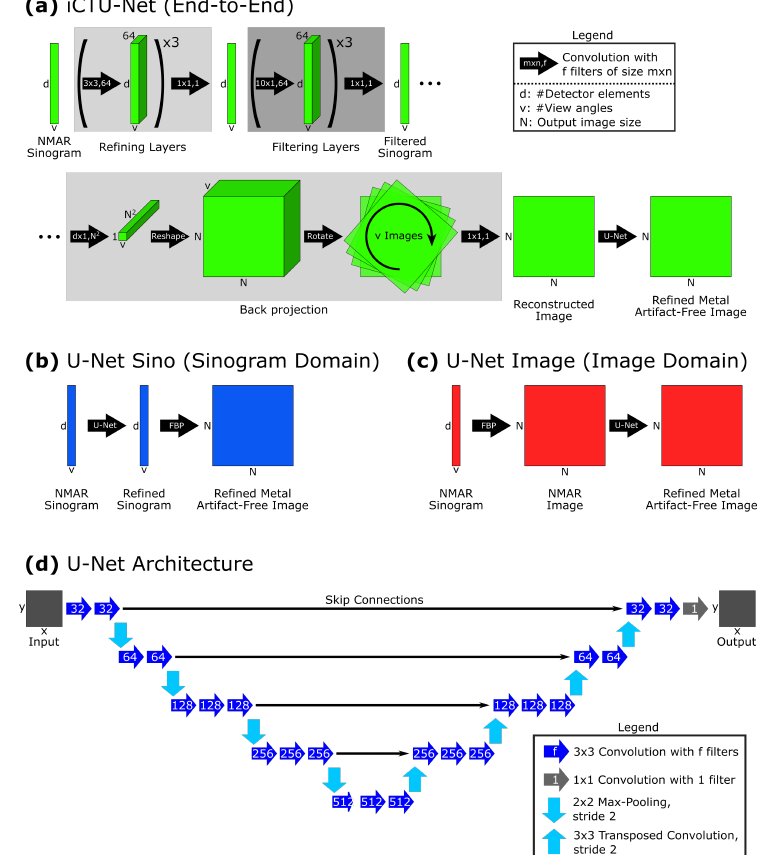
Figure 1. Deep learning architectures for metal artifact reduction. ( a ) iCTU-Net end-to-end CT reconstruction network architecture. ( b ) Sinogram domain U-Net. ( c ) Image domain U-Net. ( d ) U-Net network architecture used in the three networks in ( a – c